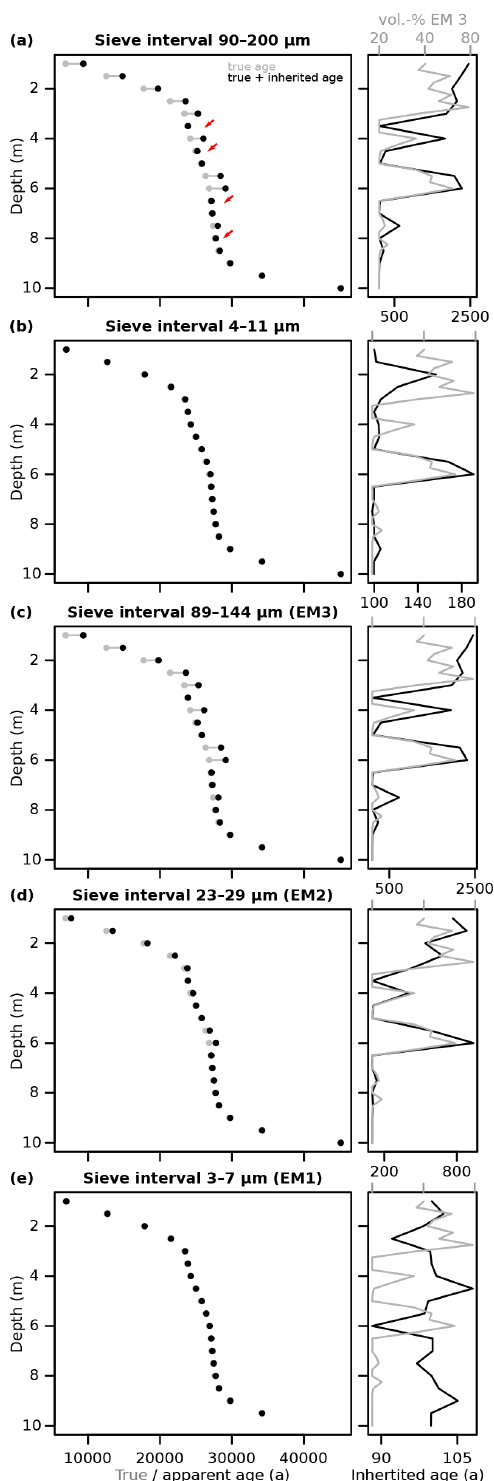
Figure 5. Age inheritance effects due to different sieve intervals of the modelled Gleina section. (a) Typical coarse-grain sieve intervals. (b) Typical fine-grain sieve intervals. (c–e) Optimised sieve intervals to isolate the three inherent grain-size end-members as well as possible. See Fig. 2 for interval definitions. The left plot panels show average true depositional ages (grey dots) and apparent measurement ages (black dots), composed of true and inherited ages per grain. Right plot panels show age inheritance (black lines) and contribution of end-member 1 (grey lines) as a function of depth. Red arrows mark age